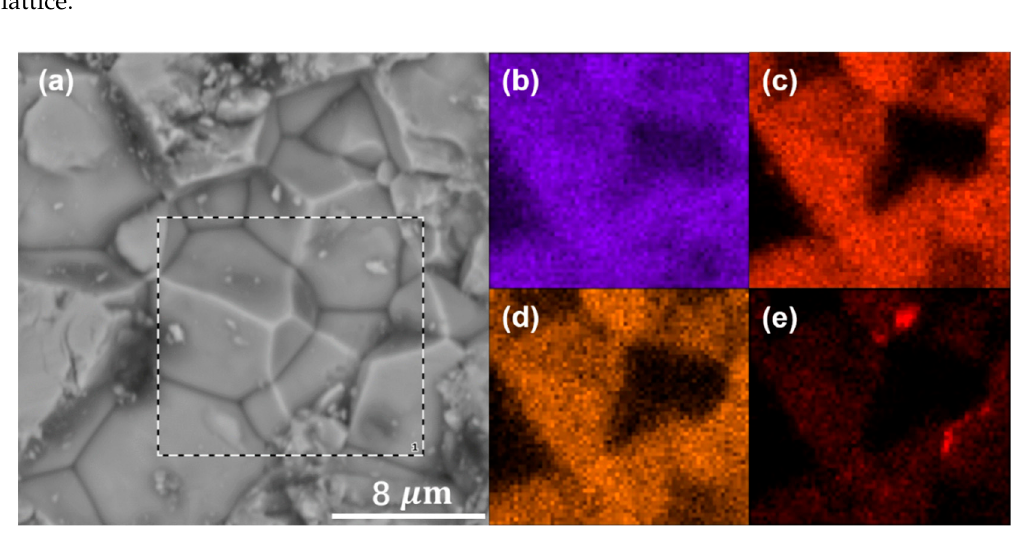
Figure 5. EDS mapping on the surface of Li 6.5 Mg 0.05 La 3 Zr 1.6 Ta 0.4 O 12 sintered by SPS at 1050 °C: ( a ) mapping area, ( b ) La, ( c ) Zr, ( d ) Ta, and ( e ) Mg.